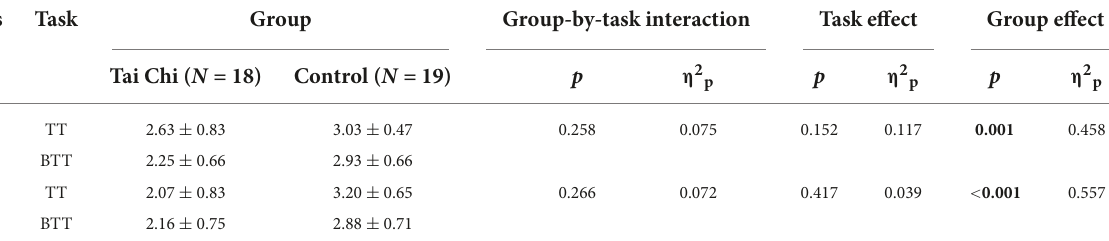
TABLE 2 Time to stabilization (TTS) in the anterior-posterior (AP) and mediolateral (ML) directions during the touch task (TT) and blind touch task (BTT). Variables Task Group Group-by-task interaction Task effect Group effect